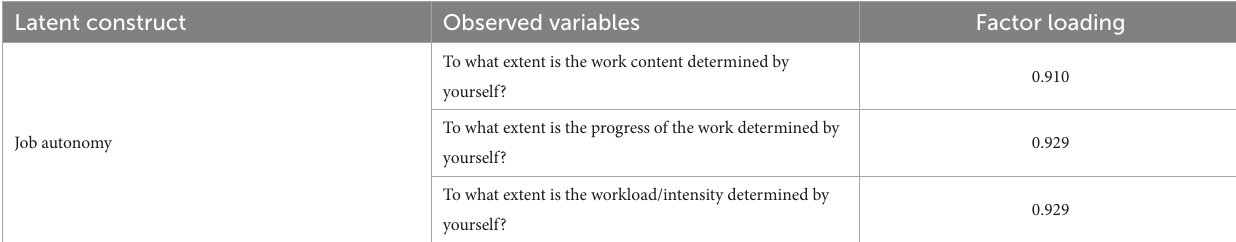
TABLE 1 Standardized factor loadings of the observable